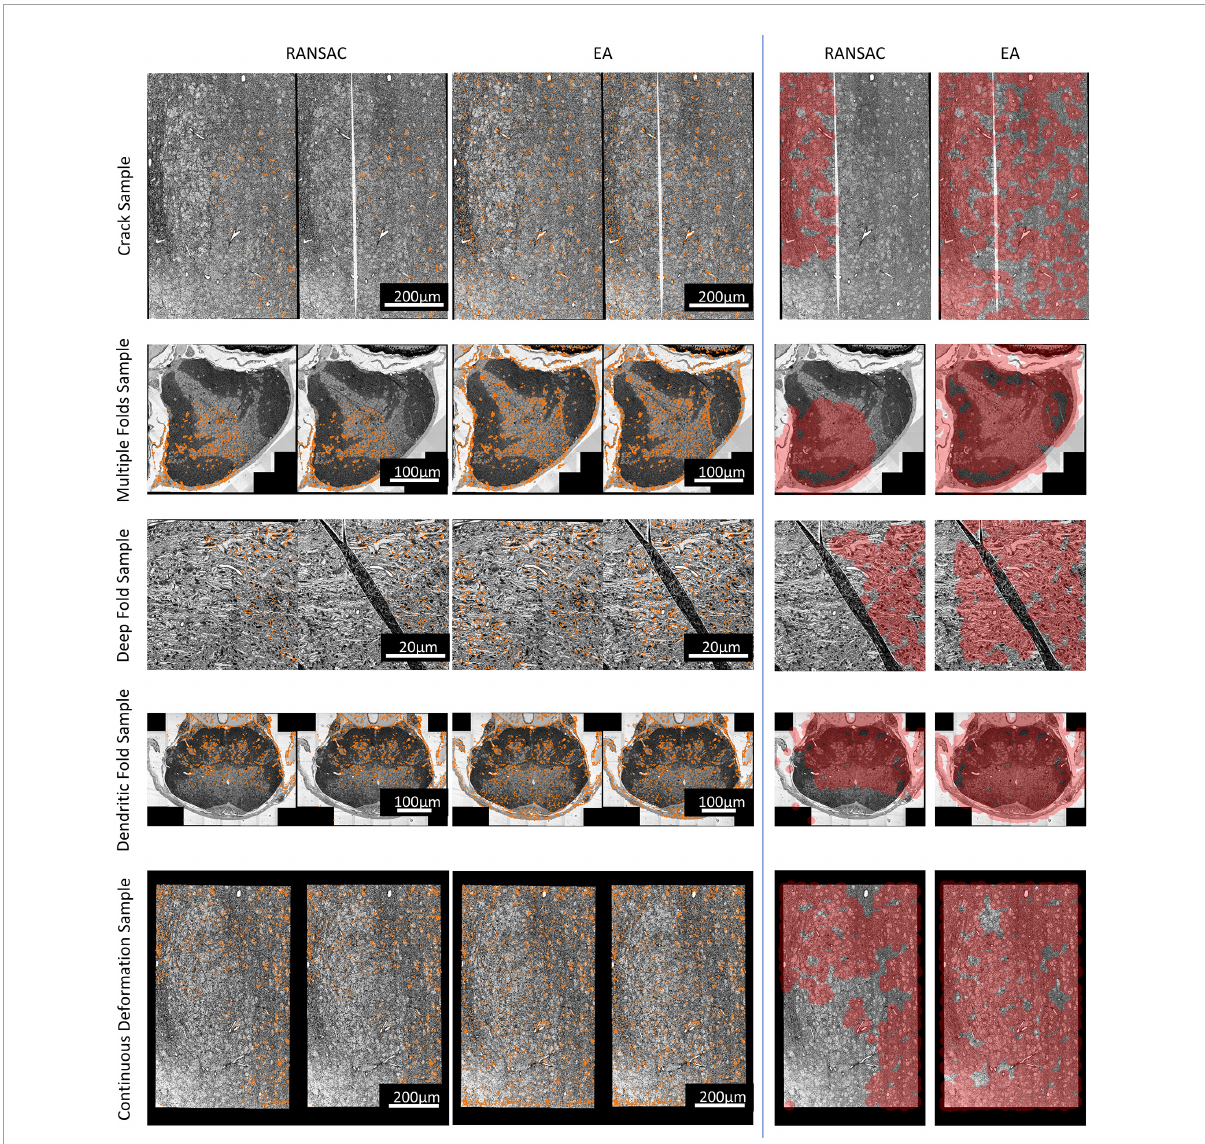
FIGURE3 The match results. Left: The matched points in the sections. For each pair, the left is the reference section, and the right is the damaged section to be registered. Right: Area covered by correspondences on different sections (the shorter side of each section is scaled to 1,000 pixels, and the red-colored area represents the area covered by